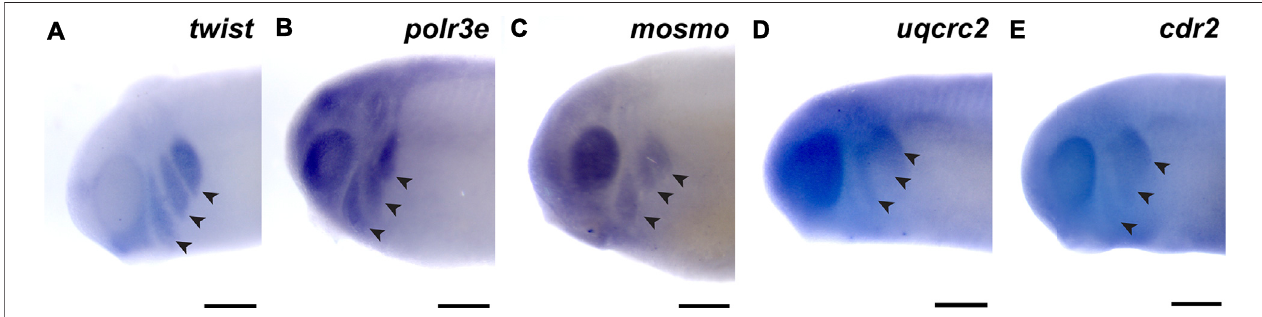
FIGURE 1 | 16p12.1-affected genes are expressed in migrating neural crest cells during embryonic development. (A) Lateral view of whole-mount in situ hybridization at stage 25 for twist , a NCC-enriched transcription factor. Anterior of embryo is to left. Arrows indicate the pharyngeal arches (PAs). (B – E) In situ hybridization at stage 25 – 28 for polr3e , mosmo , uqcrc2 , and cdr2 demonstrate expression in NCCs that occupy the PAs ( n = 10 per probe). Scalebar = 300 μ m.